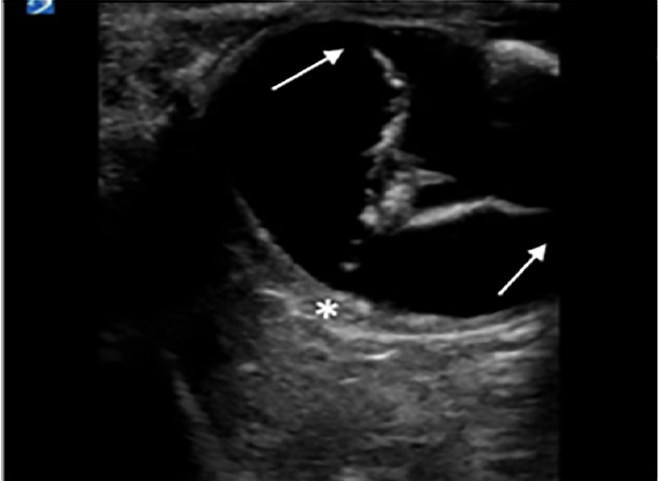
Image 1. Right eye transverse view showing retinal separation with attachment at the level of the optic disc (*) and ora serrata